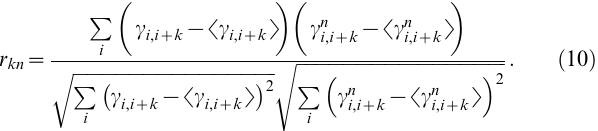
Table S2 lists such correlations for contact orders in the range 1 # k # 5.